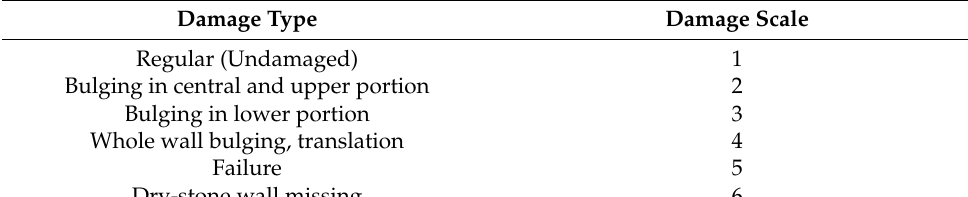
Table 1. Damage type classification developed for this study (cf., Figures 2B and 3).